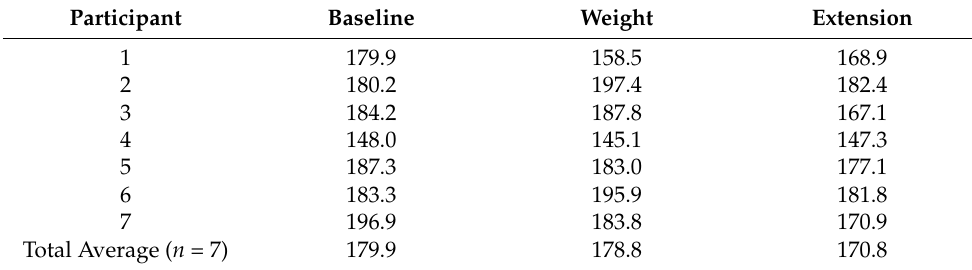
Table 2. Participants’ average release-point-to-bullseye distance (in cm) under each condition.